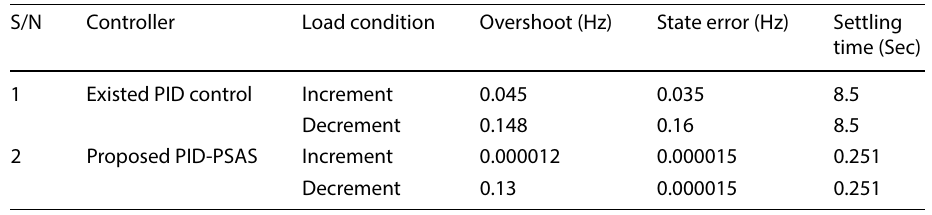
Table 3 Summarized observed results in load disturbance decrement and increment with two controller